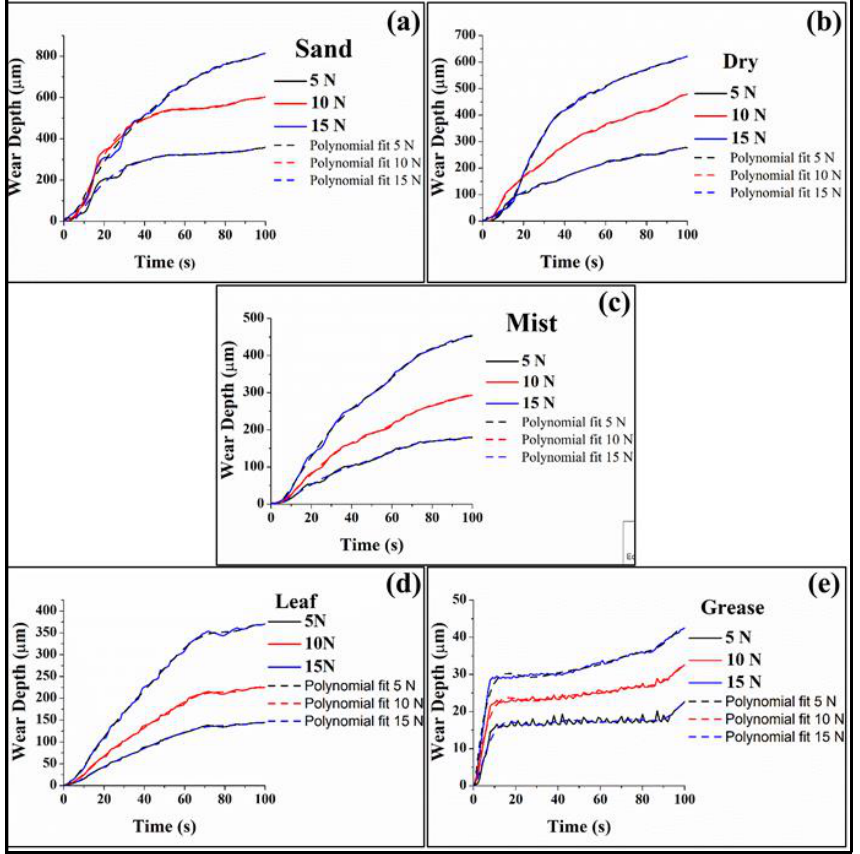
Figure 8. Effect of load on wear depth for ( a ) sand, ( b ) dry, ( c ) mist, ( d ) leaf, and ( e ) grease.